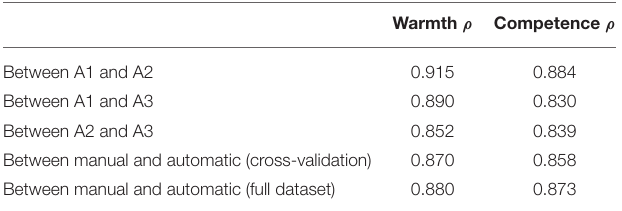
TABLE 3 | Correlation between three human annotators (A1, A2, and A3), and between manual and automatic annotations, for warmth and competence